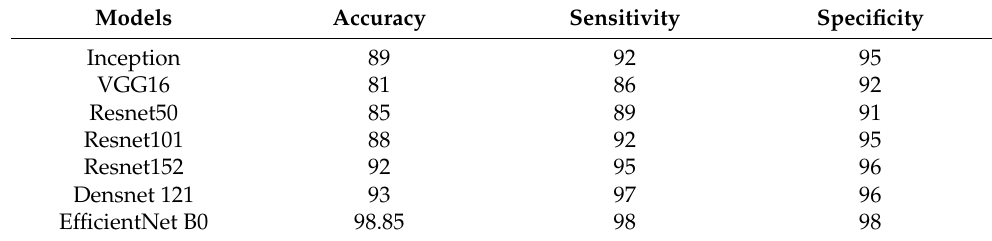
Table 5. Comparison analysis of the proposed model under Accuracy, Sensitivity, and Specificity.